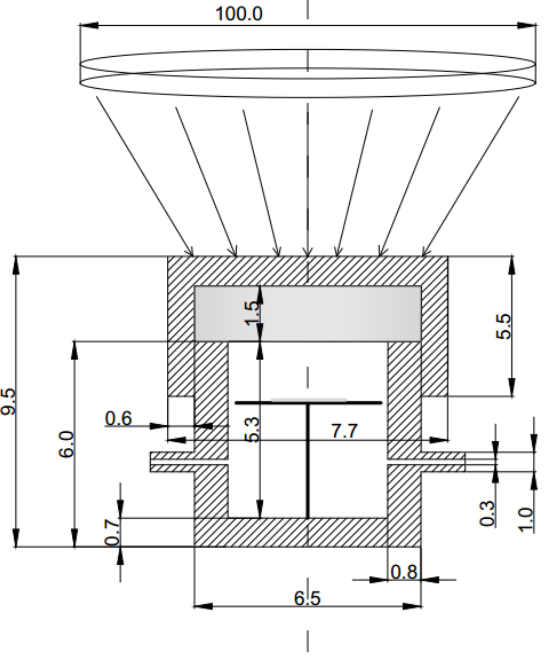
Figure 1. Side view of the concentrating reactor system (unit: cm). Table 1. Operating parameters of the concentrating solar light reactor system.